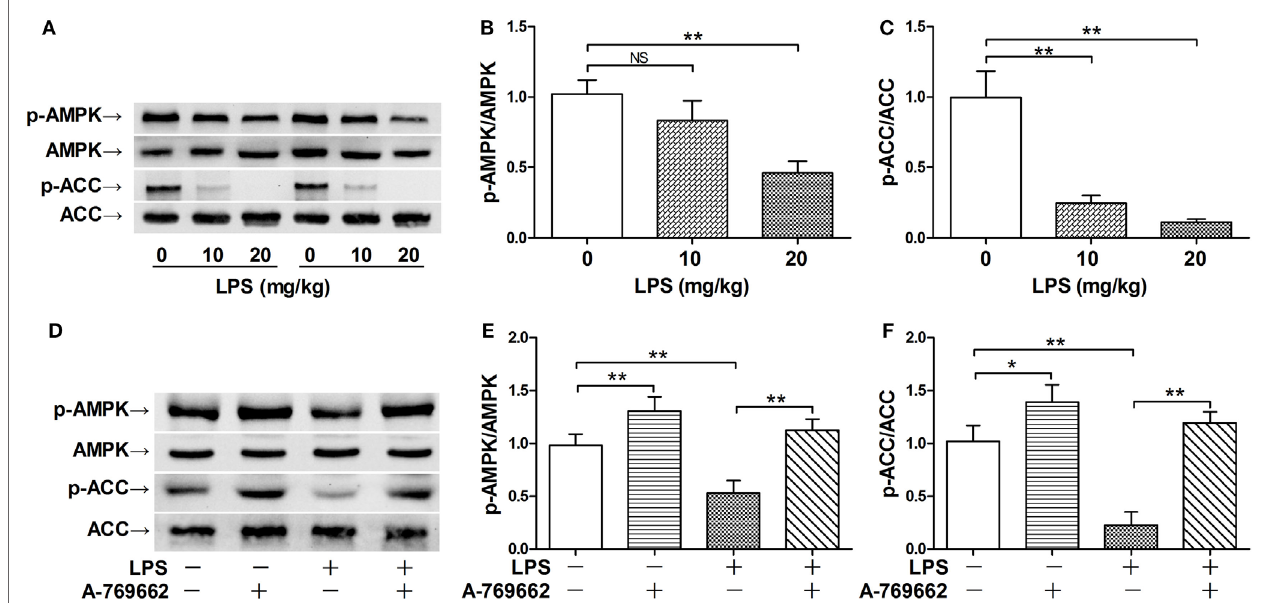
FigUre 1 | Lipopolysaccharide (LPS) exposure induced dephosphorylation of AMP-activated protein kinase (AMPK). (a–c) Mice were exposed to various doses of LPS (0, 10, and 20 mg/kg), lung samples were harvested 3 h post LPS exposure. The level of phosphorylated AMPK (p-AMPK), total AMPK (AMPK), phosphorylated ACC (p-ACC), and total ACC (ACC) was determined by immunoblot (a) , and the blots were semi-quantified (B,c) ( n = 4). (D–F) Mice were exposed to LPS (20 mg/kg), vehicle or AMPK activator A-769662 was administered 30 min before LPS exposure. The level of p-AMPK, AMPK, p-ACC, and ACC was determined by immunoblot (D) , and the blots were semi-quantified (e,F) ( n =